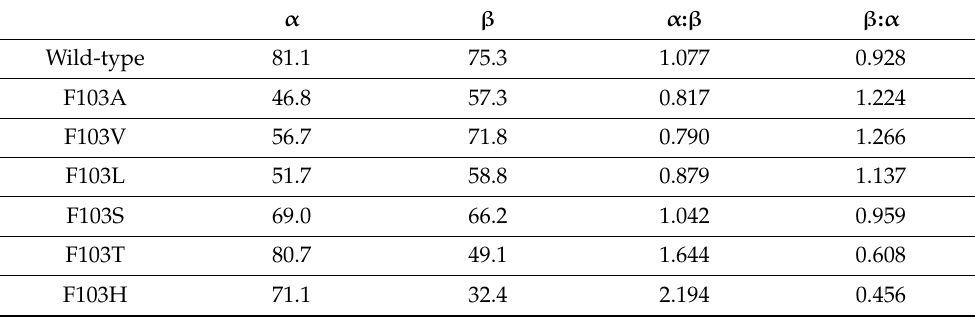
Table 1. The calculated abundances of the α and β subunits for wild-type LigAB and F103 α mutants. The ImageQuant calculated abundance of each α and β subunit in the elution fractions E 3–1 to E 3–5 compared to the relative abundances of the subunit in all the elution fractions (see Supplemental Figures S2 and S3). The ratios of α to β and β to α are also reported as a basis of comparison. α β α : β β : α Wild-type 81.1 75.3 1.077 0.928 F103A 46.8 57.3